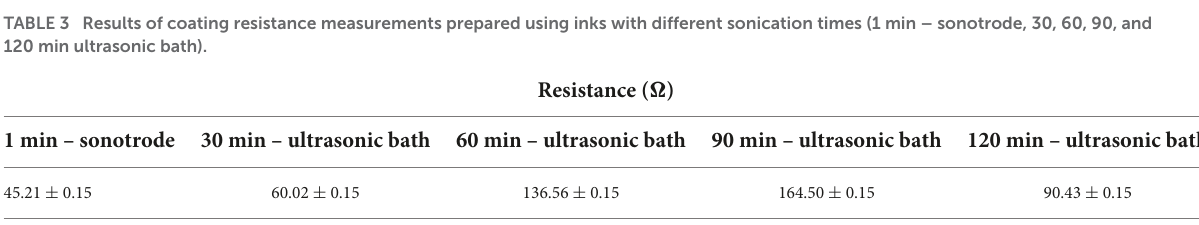
TABLE 3 Results of coating resistance measurements prepared using inks with different sonication times (1 min – sonotrode, 30, 60, 90, and 120 min ultrasonic bath).